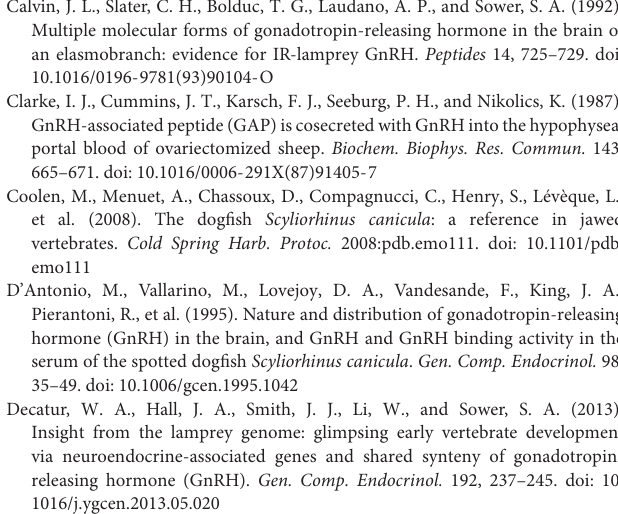
Supplementary Data Sheet S6 . Legends are the same as in the Supplementary Data Sheet S4 .